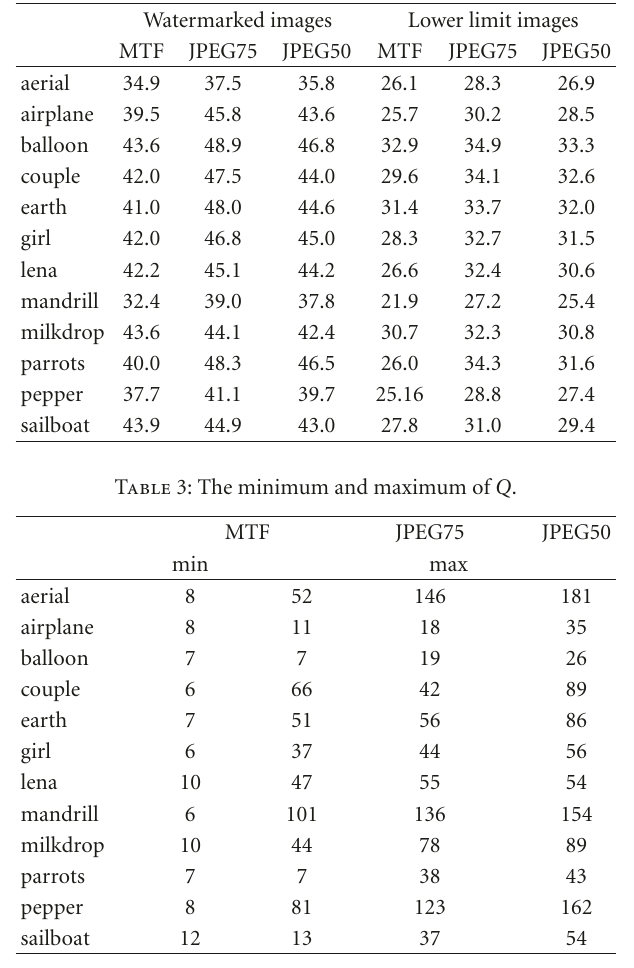
Table 2: PSNRs of watermarked images and lower limit images against original images.